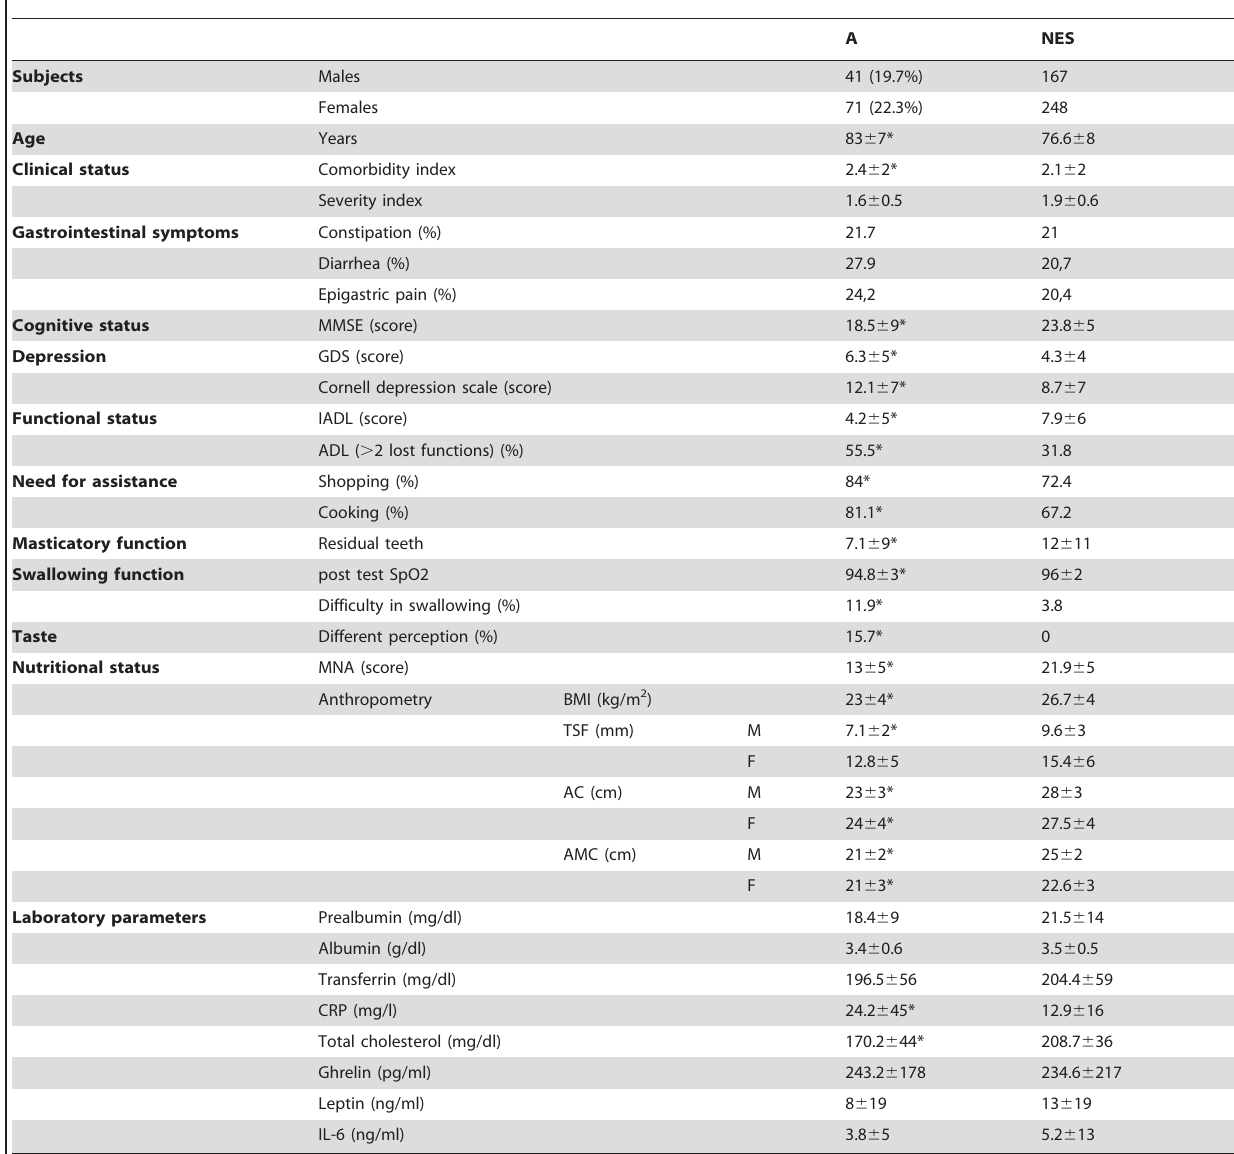
Table 2. Baseline Characteristics of the Sample According to the Diagnosis of Anorexia 1